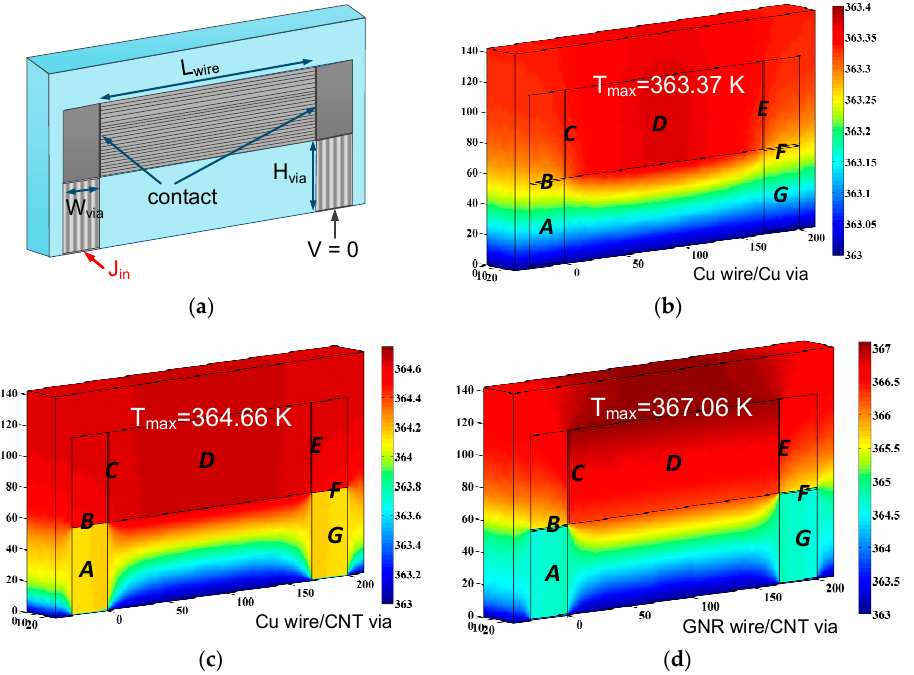
Figure 15. ( a ) Schematic of a simulation model. ( b – d ) Temperature profiles of Cu, SWCNT vias/Cu